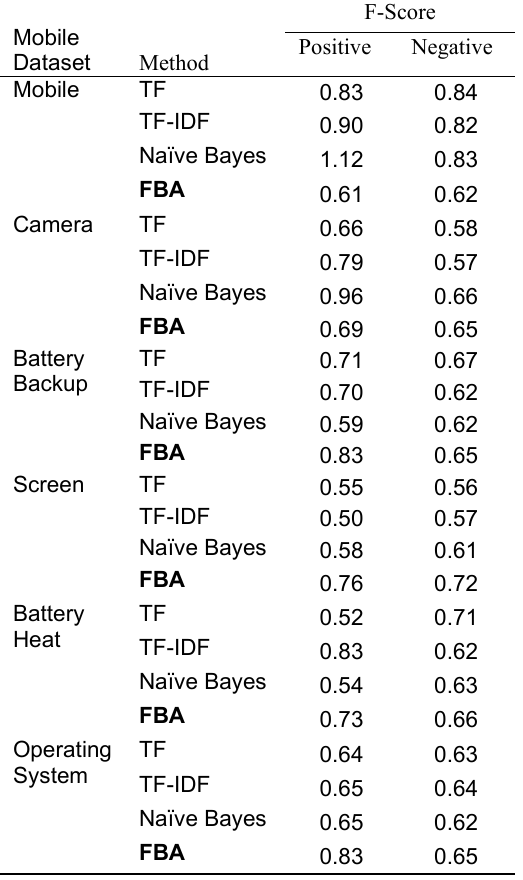
Table 8. Performance evaluation of FBA with TF, TF- IDF and Naïve Bayes using F-Score